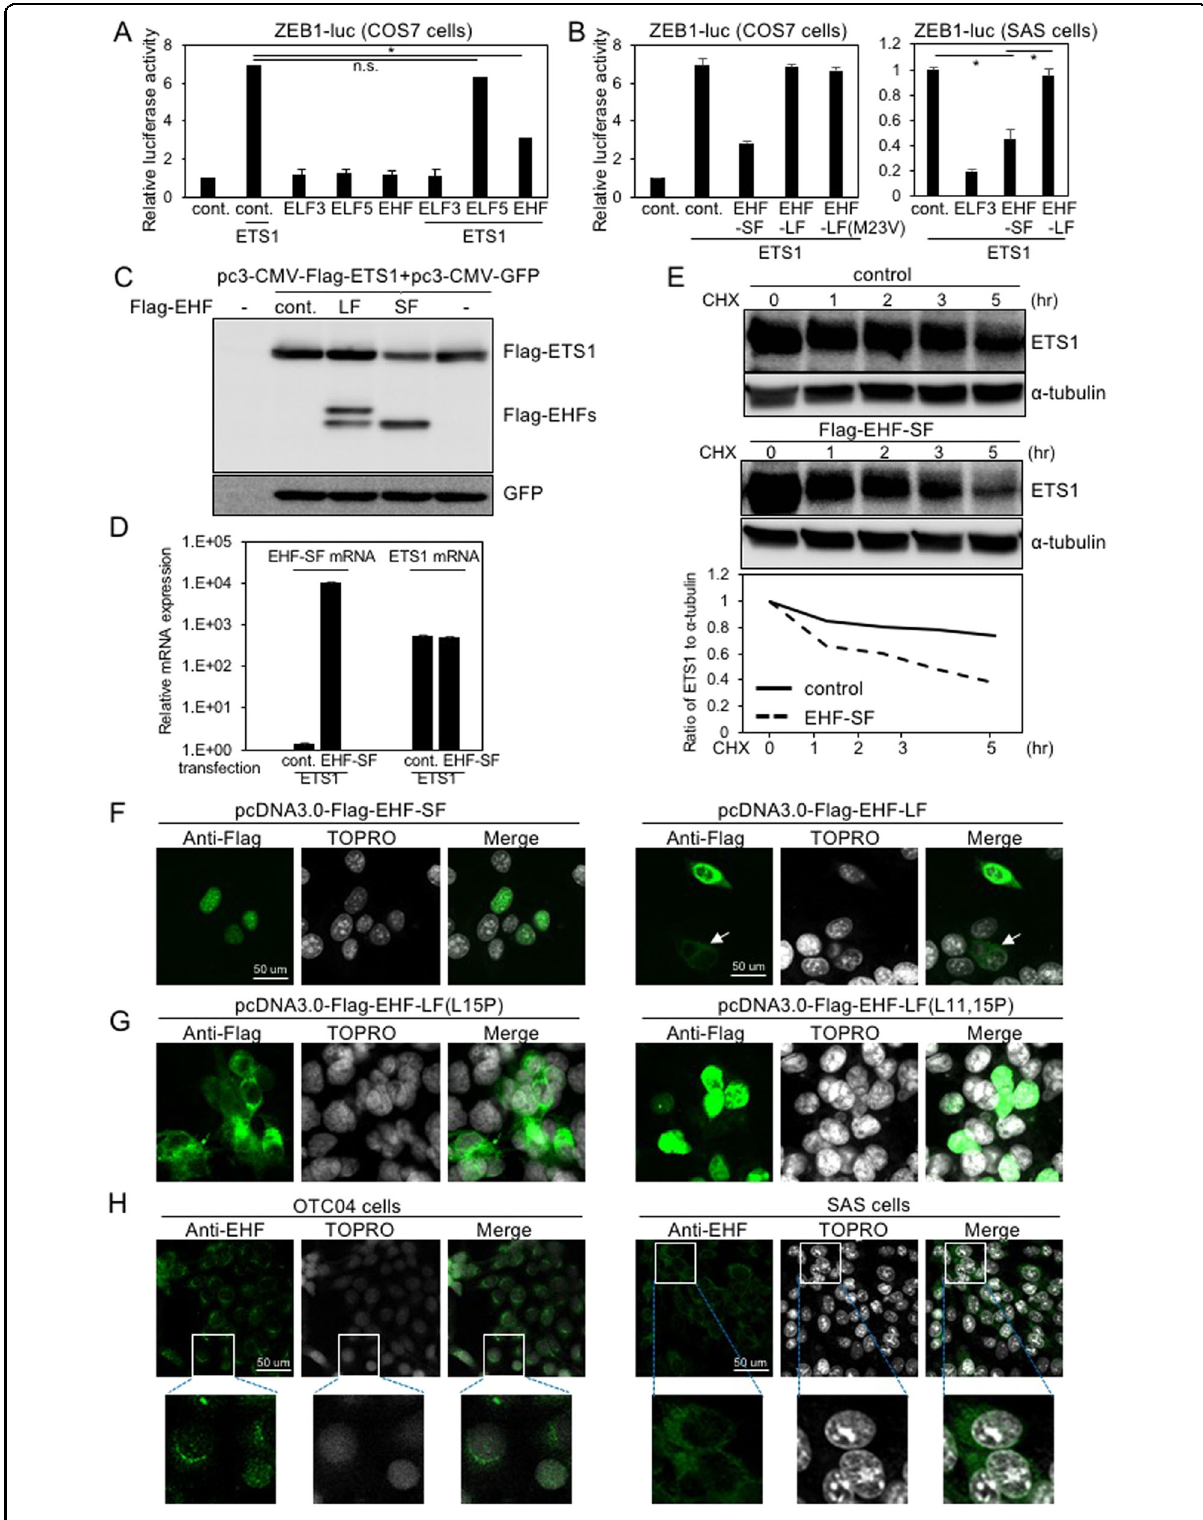
Fig. 3 (See legend on next